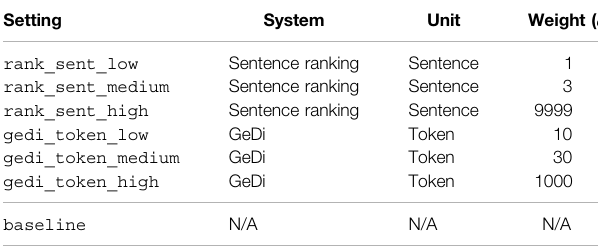
TABLE 11 | Sentiment steering settings compared.